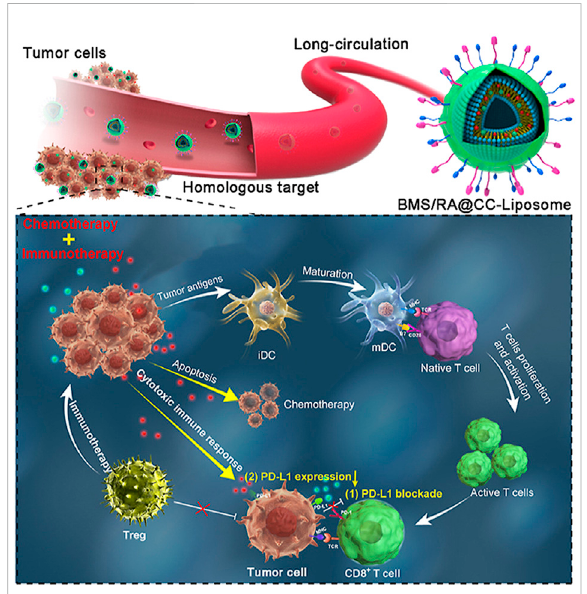
FIGURE 2 NDDS based on tumor membrane camou fl age for hypoxic tumor chemotherapy and immunotherapy. Copyright Year 2022, Acta Pharmaceutica Sinica B (Yao et al.,